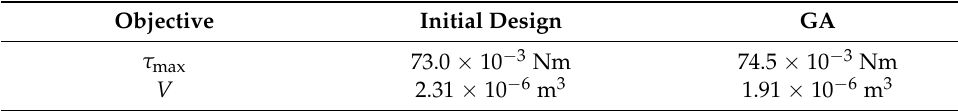
Table 3. Optimization parameters and their levels.